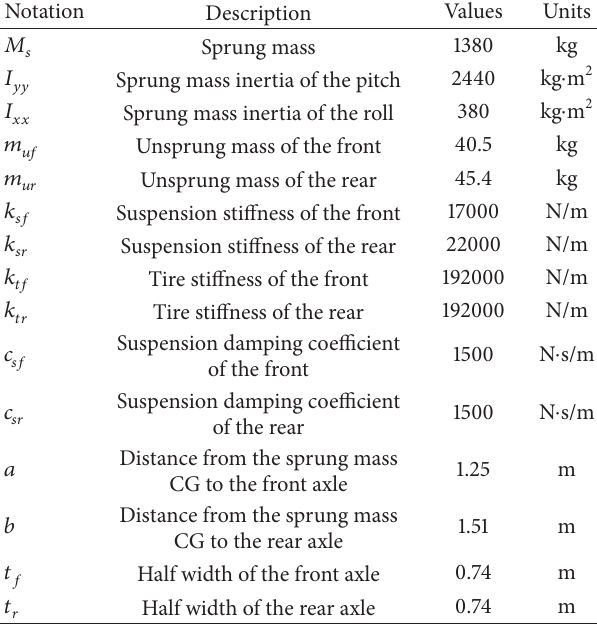
Table 1: The physical parameters of a 7-DOF vehicle